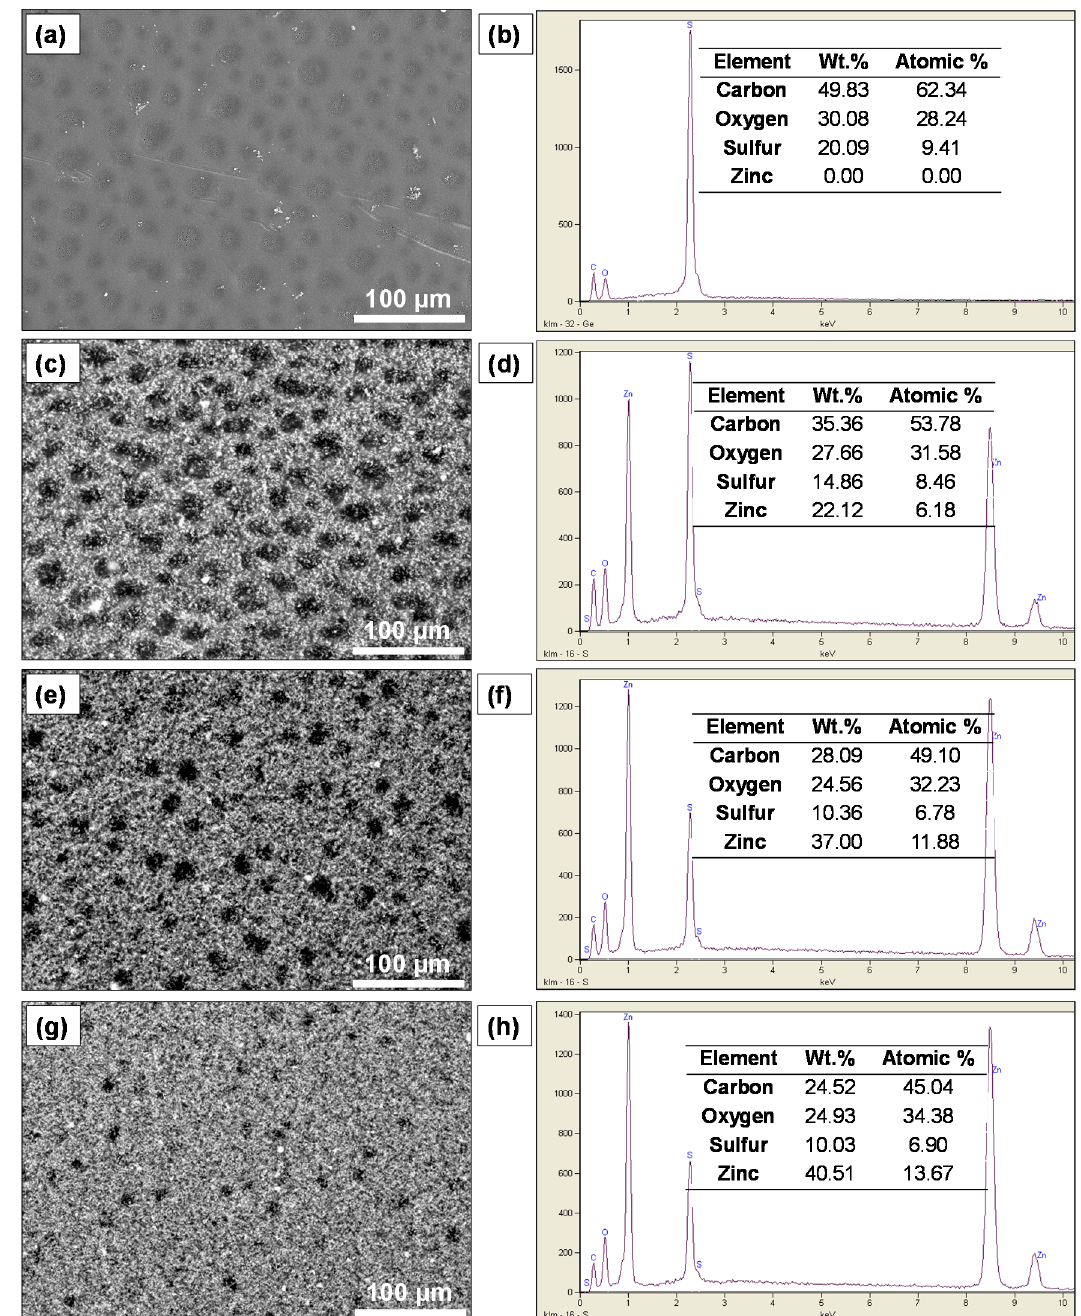
Figure 2. The surface scanning electron microscopy (SEM)–energy dispersive X-ray (EDX) micrographs of the PES/ZnO film photocatalysts by varying weight percentages of ZnO in the polymer solutions, ( a , b ) 0%, ( c , d ) 9%, ( e , f ) 17%, and ( g , h ) 19%.